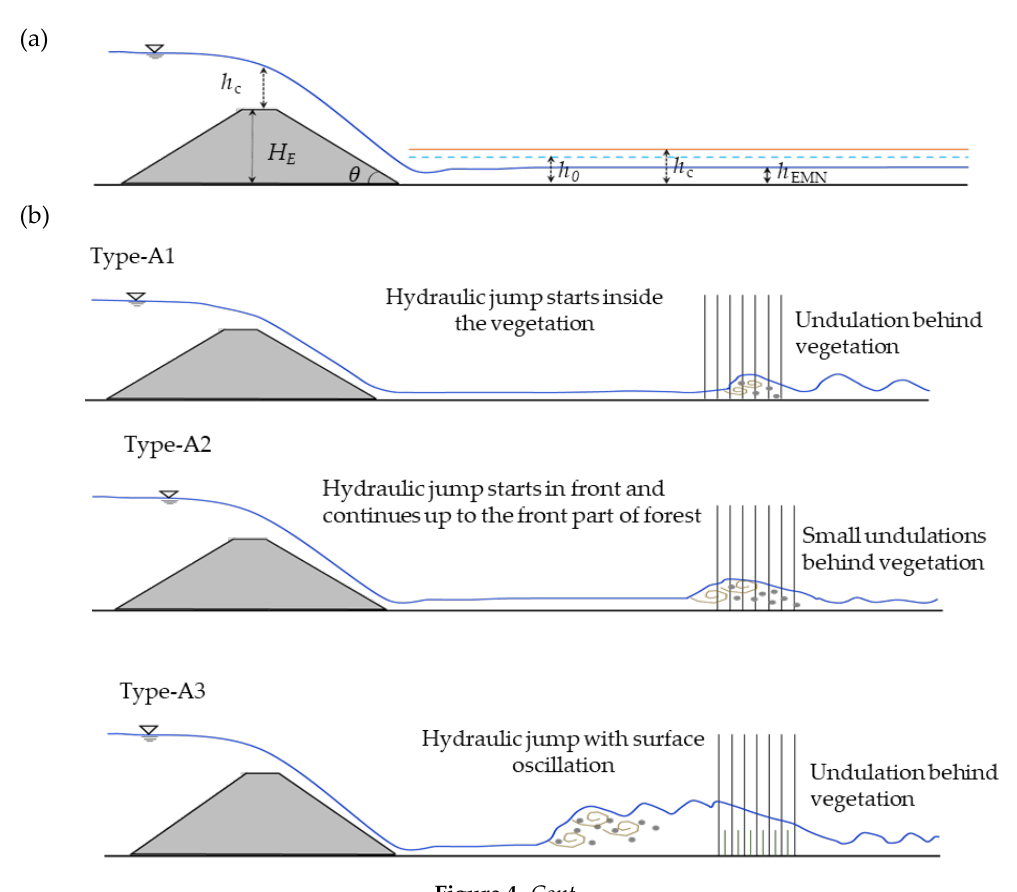
Table 2. Flow condition in the defense system and hydraulic jump position on the embankment